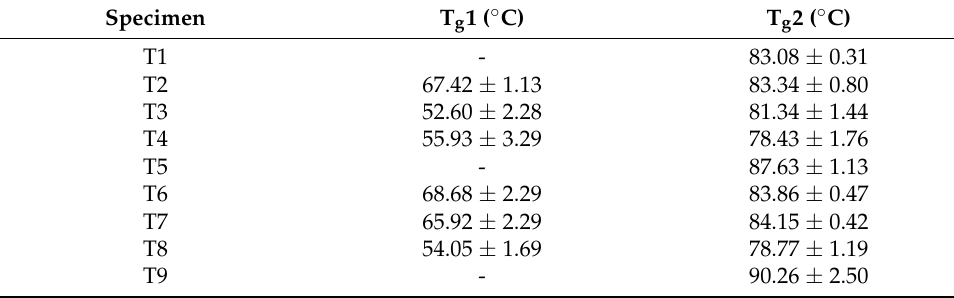
Figure 6. The dynamic properties of Specimen T3 measured with the temperature sweeping from 30 ◦ C to 140 ◦ C. Table 3. Glass transition temperatures of the